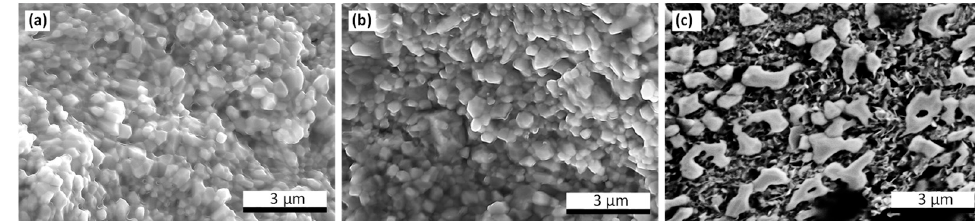
Figure 1. SEM images of the fractured surfaces of the (1- x )BMT– x BZT sample ( x = 0.70) synthesized under high pressure: ( a ) as prepared, ( b ) annealed at 770 K and ( c ) annealed at 970 K.